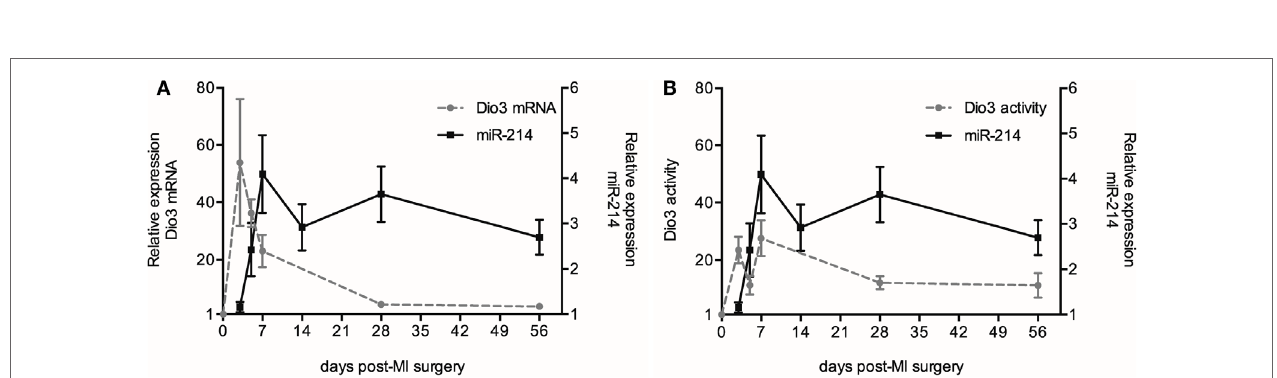
FigUre 6 | Time course of mir-214 expression, Dio3 mrna and Dio3 activity after Mi . For the sake of clarity, the miR-214 data are shown in separate panels in combination with Dio3 mRNA expression (a) and Dio3 activity (B) . The different parameters are expressed relative to their basal expression level determined in sham-operated mice at day 7. Dio3 mRNA and Dio3 activity data from this set of samples were published in part before (8). Values are means ± SEM, miR-214 ( n = 5), Dio3 mRNA ( n 3d = 7, n 5d = 6, n 7d = 16, n 28d = 10, n 56d = 16) and Dio3 activity ( n 3d = 8, n 5d = 9, n 7d = 16, n 28d = 6, n 56d = 6).